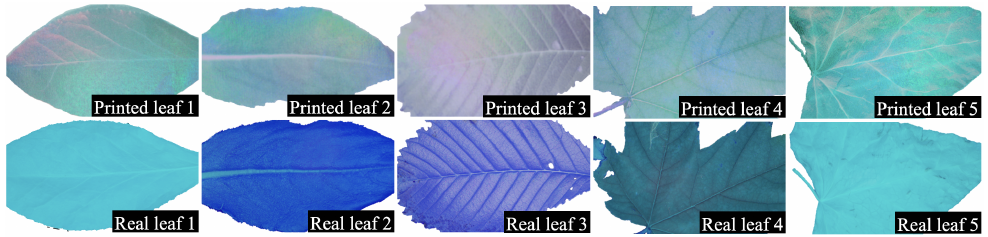
Figure 11. Comparison of printed and real leaf by the hyperspectral camera. Synthetic RGB images of leaf pairs generated from the bands have the most significant absolute differences between the real and printed leaf images as collected by our active and low-cost hyperspectral camera.